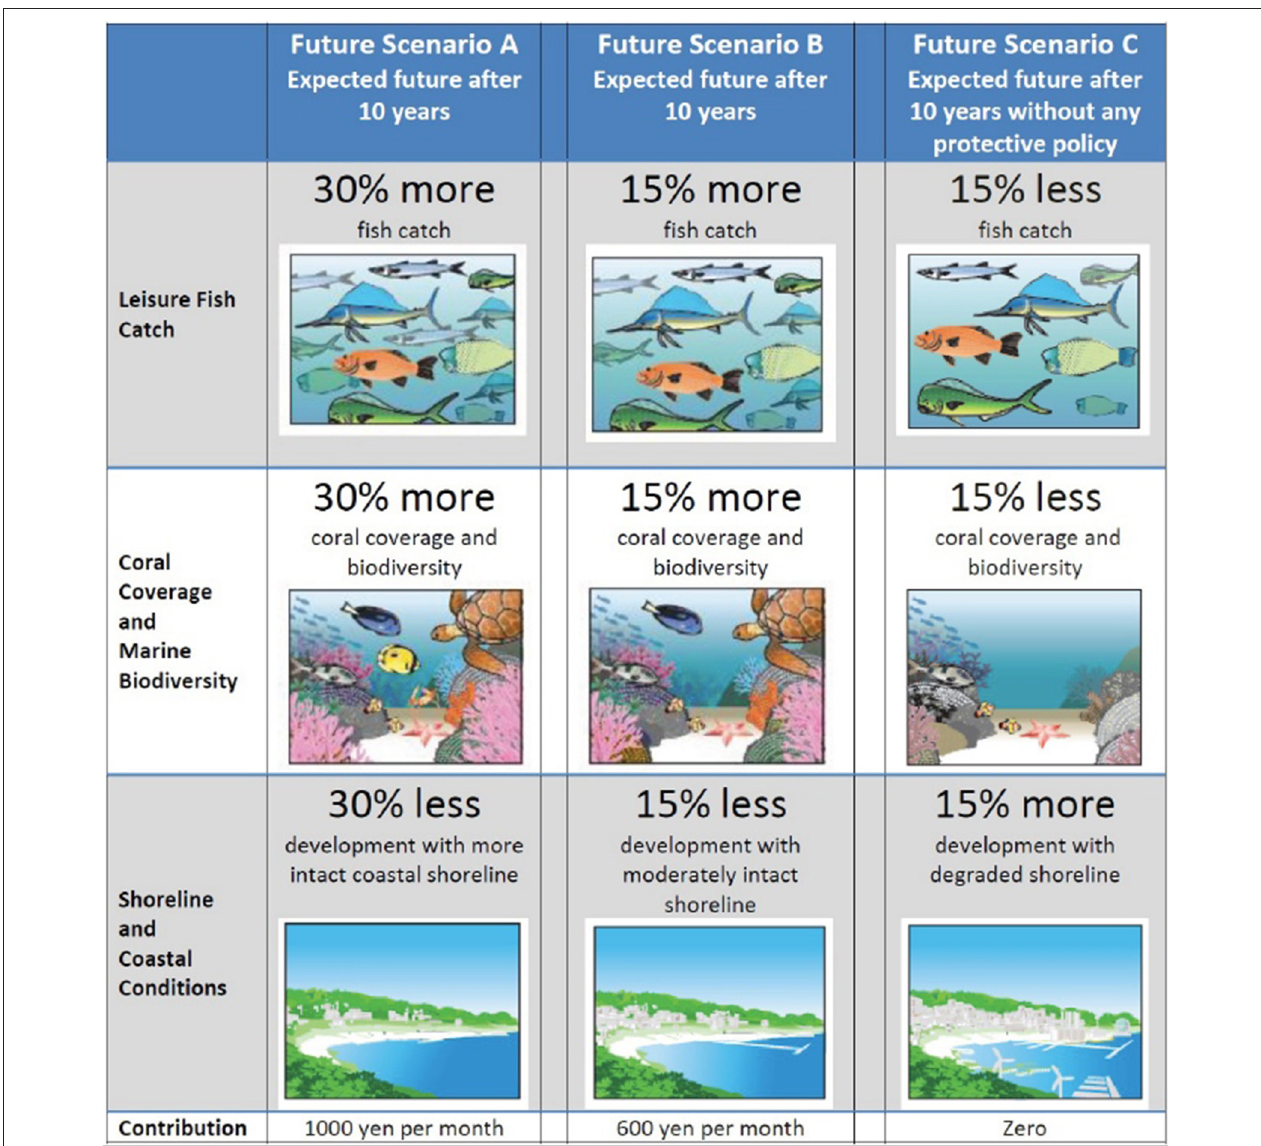
FIGURE 1 | Choice experiment survey example question. Respondents were asked to choose among three future scenarios, two of which involved the creation of a protected area (A,B) and one of which did not (C) . For each scenario, expected outcomes for three attributes (leisure fish catch, coral coverage and marine biodiversity, and shoreline and coastal development) were presented, along with the expected monthly personal contribution associated with each scenario.